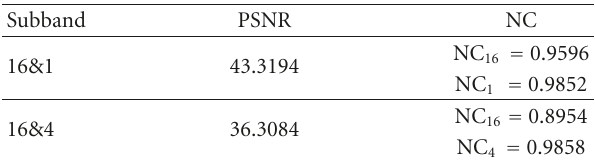
Table 1: Results of embedding data in the highest frequency subband of the host image.